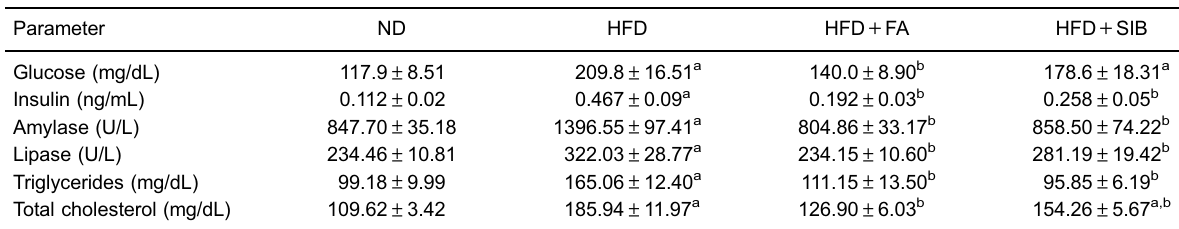
Total cholesterol